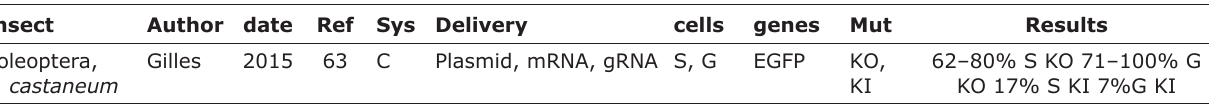
Table-1: Engineered endonuclease-based gene editing in Tribolium [26].